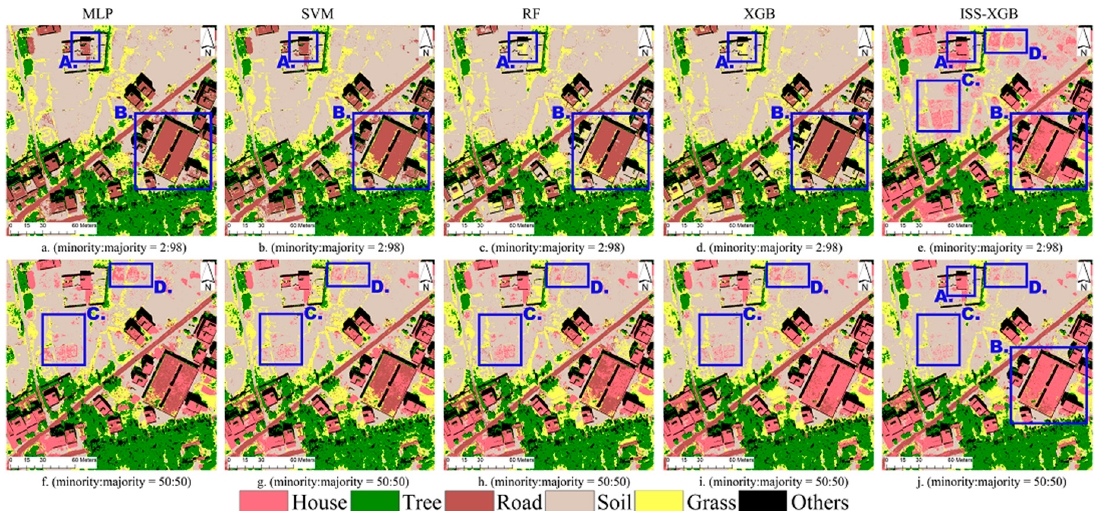
Figure 4. Classification maps of MLP, SVM, RF, XGB, and ISS-XGB with di ff erent imbalanced samples (minority:majority = 2:98 or 50:50). Sub-figure ( a – e ) shows the classification maps by di ff erent methods with a sample ratio at 2:98 (( a ): MLP; ( b ): SVM; ( c ): RF; ( d ): XGB; ( e ): ISS-XGB). Sub-figure ( f – j ) shows the classification maps by di ff erent methods with a sample ratio at 50:50 (( f ): MLP; ( g ): SVM; ( h ): RF; ( i ): XGB; ( j ): ISS-XGB).